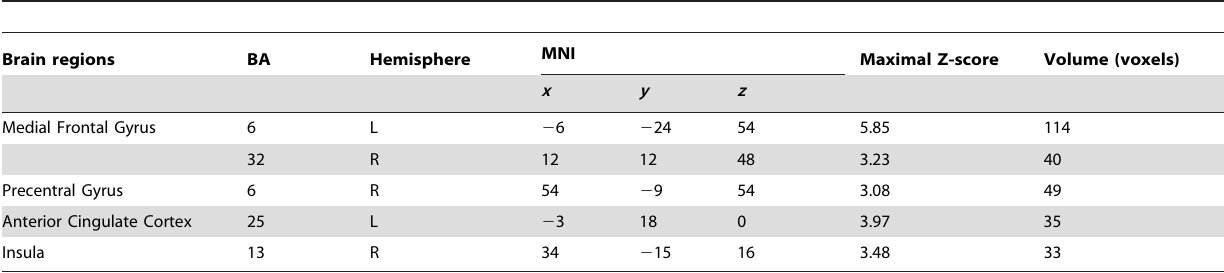
Table 5. Brain areas with significant different ReHo values in the healthy controls after acupuncture at P , 0.01 (Alphasim corrected, p , 0.01, 30 voxels).